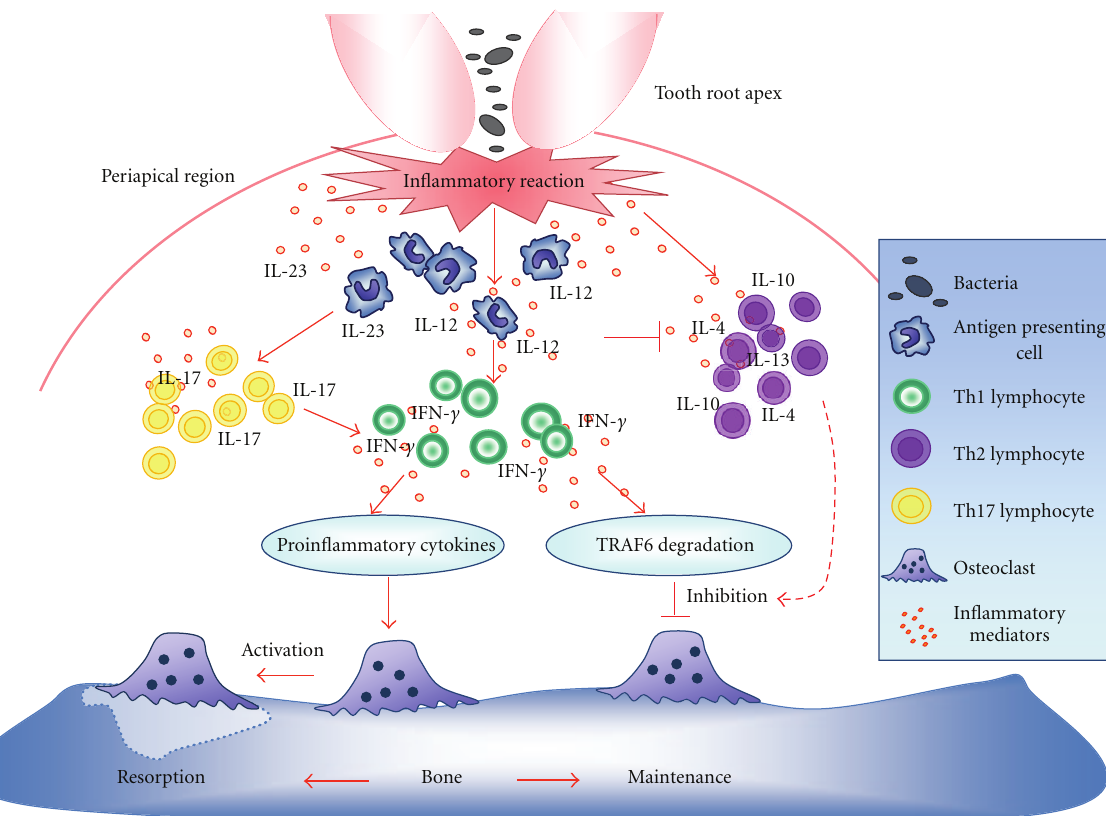
Figure 1: Schematic drawing showing the controversial role of IL-12 on bone resorption at apical periodontal sites. The progression of dental pulp infection triggers an inflammatory response in periapical tissues. Inflammatory cells, such as macrophages, are recruited for that region and release proinflammatory mediators. One of those mediators is IL-12, which induces Th1 cells to produce IFN- γ . The IL-12-IFN- γ pathway can induce bone resorption by production of proinflammatory cytokines, such as TNF- α and IL-1 β , which leads to the activation of osteoclasts. In contrast, this pathway is also involved in the degradation of the RANK adapter protein, TRAF6, which reduces RANKL- induced osteoclast di ff erentiation. In this context, dendritic cells and na¨ıve CD4 + cells also produce the IL-12 family member cytokine IL-23, which induces the di ff erentiation of Th17 cells. These cells release IL-17, enhancing the IFN- γ production. In favor of this proinflammatory environment IL-12 also may blockade Th2 cytokines, stimulating the progression of infection-induced periapical lesions. These opposing mechanisms may explain the discrepant findings regarding IL-12 and IFN- γ in the pathogenesis of periapical lesions. IFN- γ : interferon- γ ; RANK: receptor activator of nuclear factor κ B; TRAF6: tumor necrosis factor receptor-associated factor